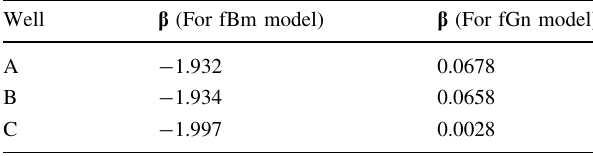
Table 7 Estimation of b for fBm, fGn models by log data